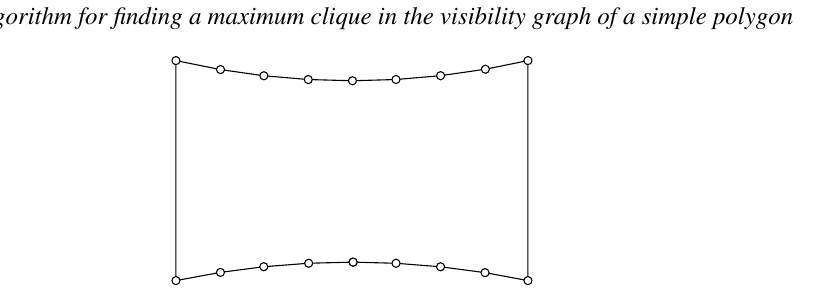
Figure 1: The visibility graph of this polygon has quadratic number of edges, while every maximum clique has only four